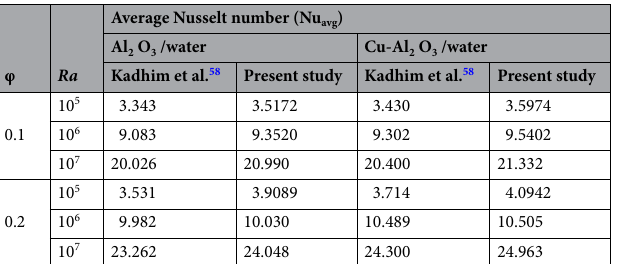
Isotherm lines distribution in the interior fluid in both right columns are parallel to the vertical walls, which means most heat is transferred through conduction. The growth of wave amplitude increases the temperature of the solid wave wall, which reduces the heat transfer by the liquid. Also, it can be seen that when A is changed, the fluid flow follows the structure’s geometry. In particular, as A increases, the maximum stream function values are decreased, while the minimum values are improved in this Ra* range. For A = 0.2, as the Ra* increases from